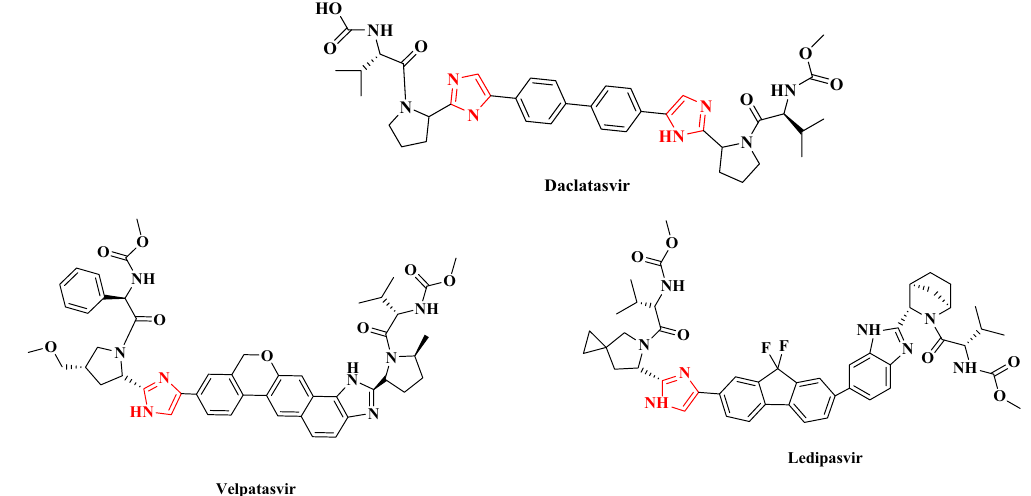
Figure 1. Examples of medicines containing the imidazole scaffold.